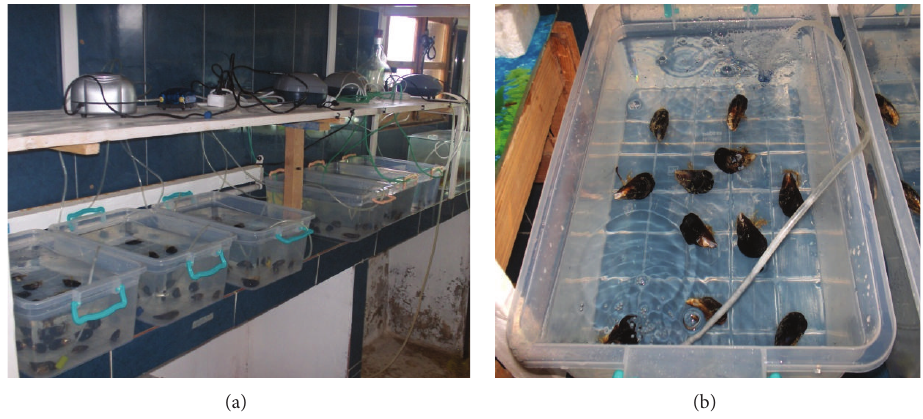
Figure 2: (a) The experimental device of the study. (b) The mussels in their